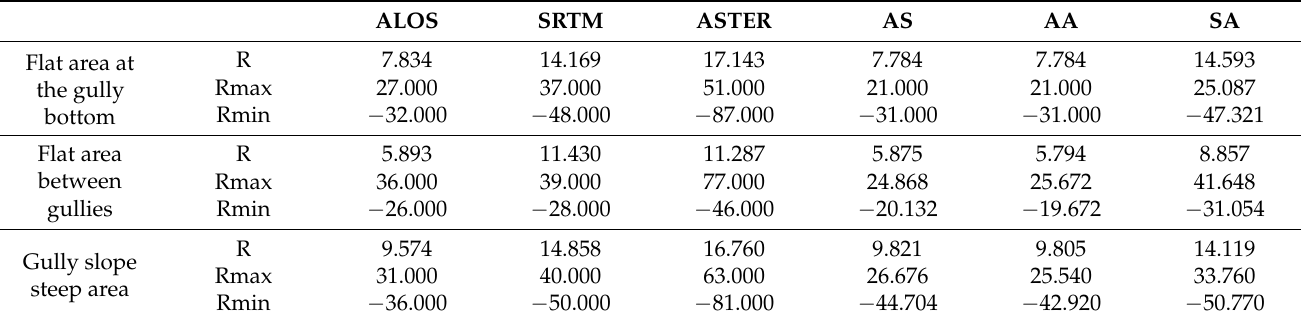
Table 10. The error statistical value of partition weighted fusion in Ganquan (unit: m). ALOS SRTM ASTER AS